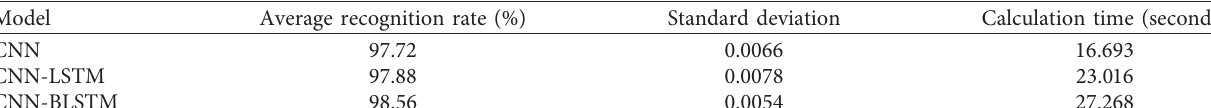
Table 4: Dividing into 10 types of test diagnosis results.